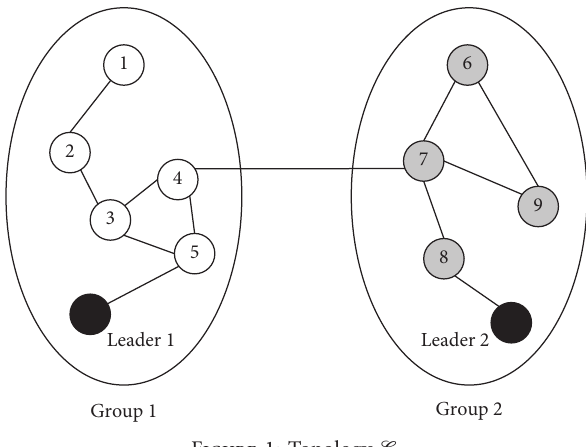
Figure 1: Topology G